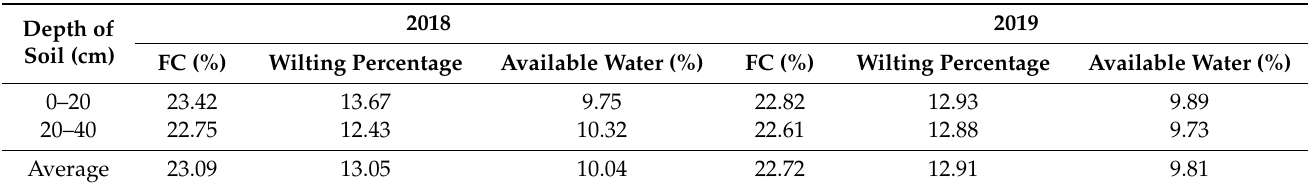
Table 3. Field capacity (FC), wilting point, and available soil water of the experimental soil in the two seasons of 2018 and